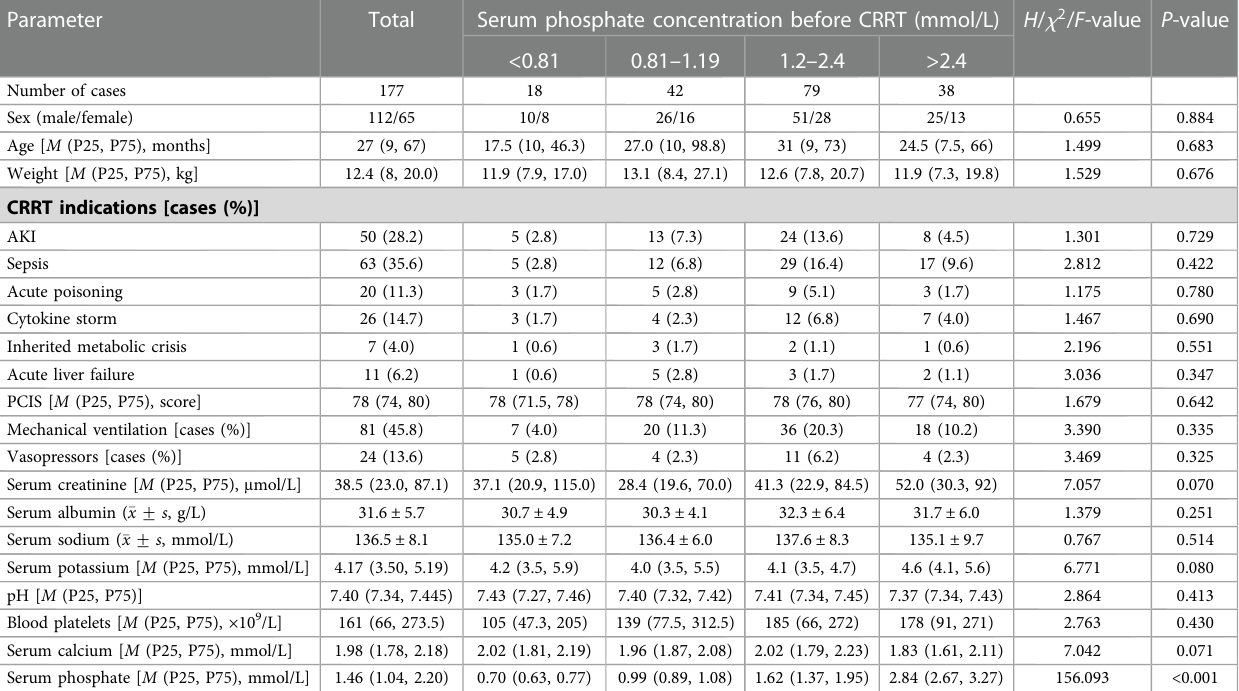
TABLE 1 Baseline characteristics of the participants before CRRT initiation.